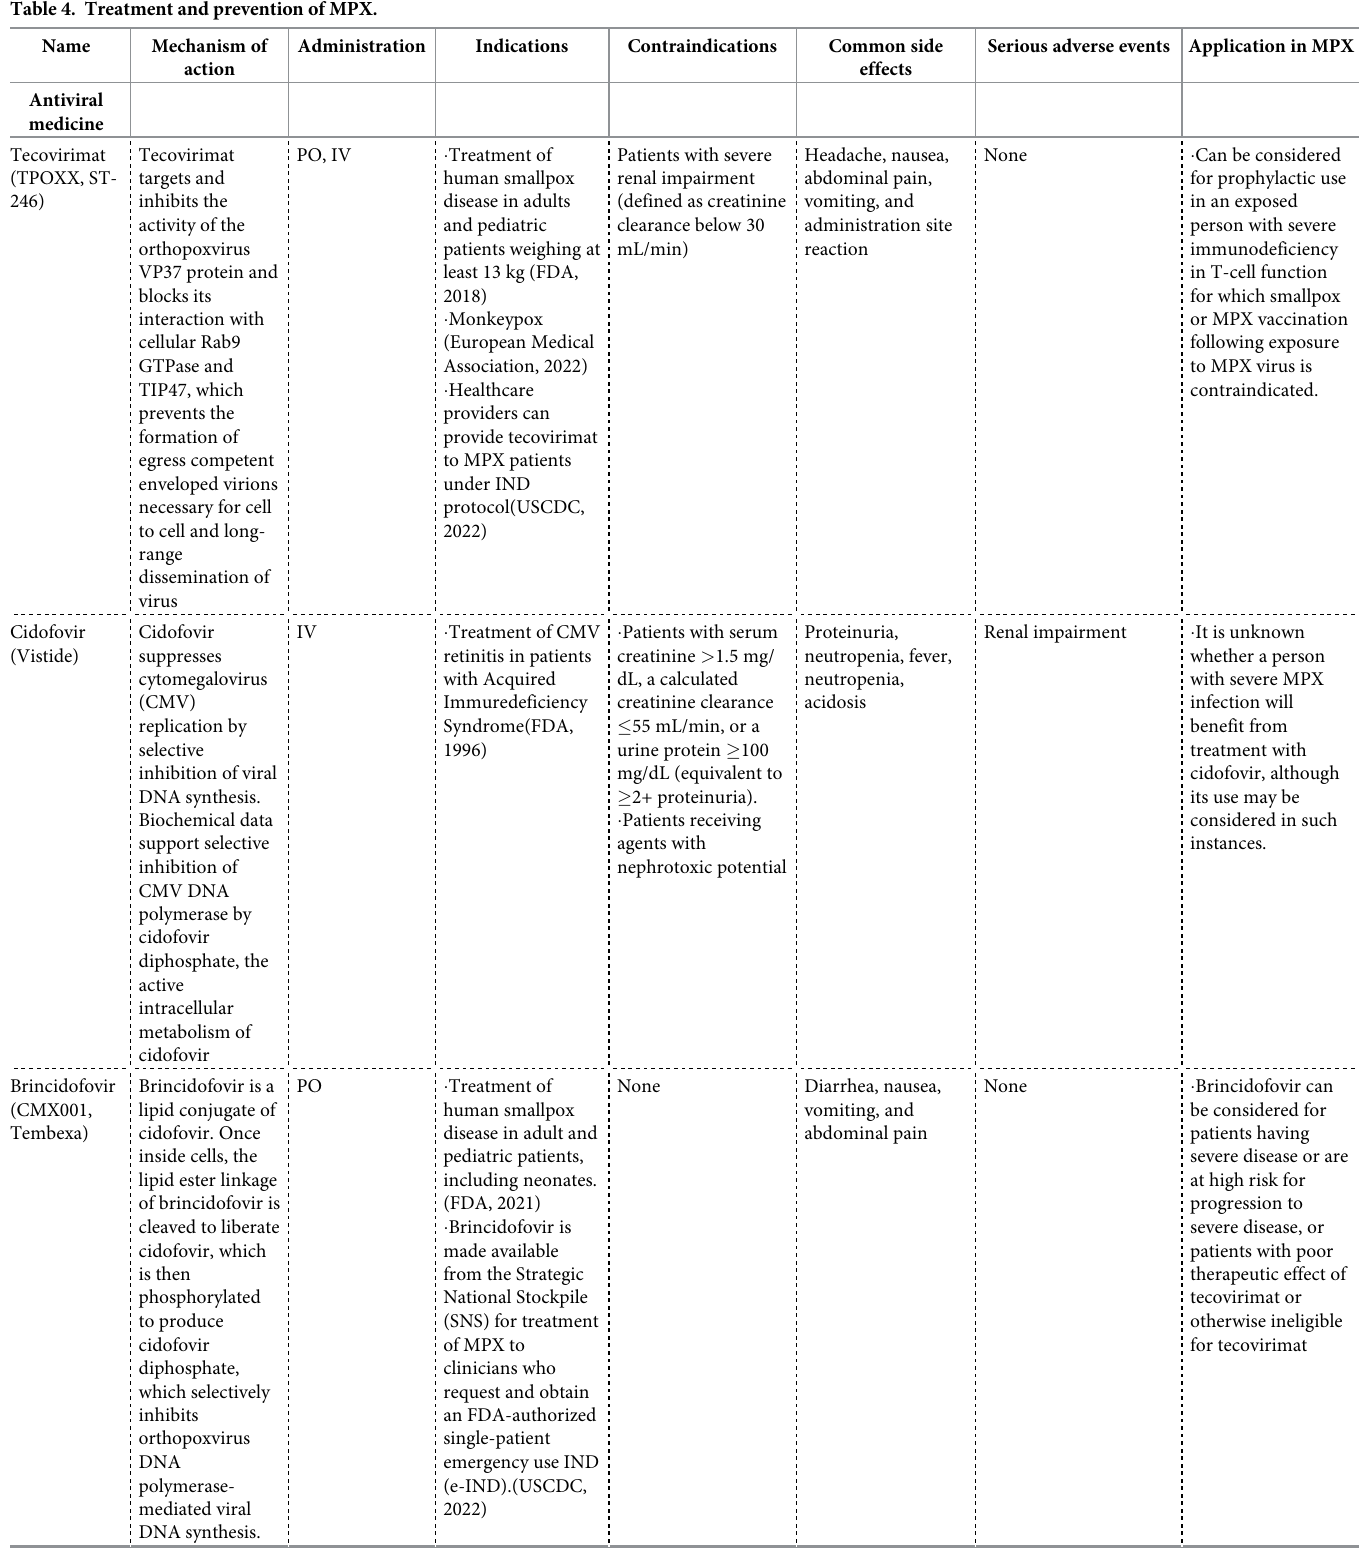
Table 4. Treatment and prevention of